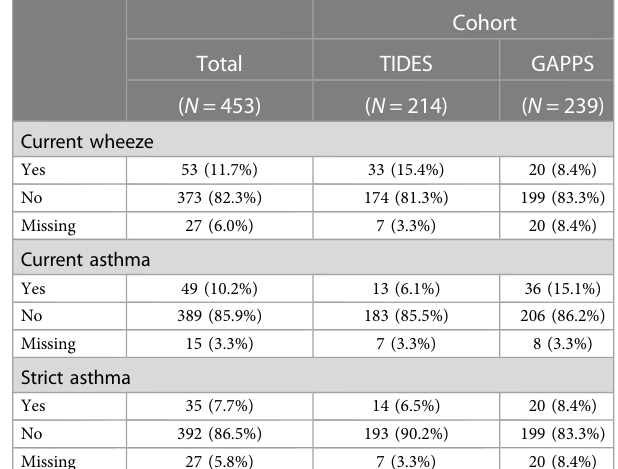
TABLE 3 Asthma and wheeze outcomes at age 4 – 6 years in the study population.